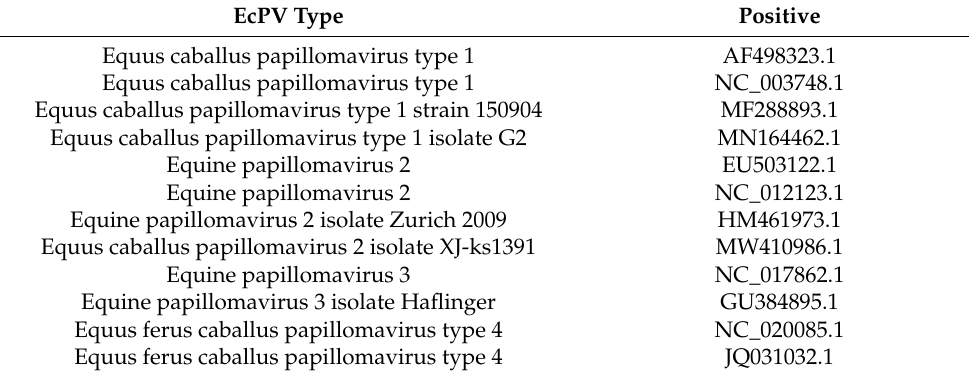
Table 2. List of the EcPV isolates and their related accession numbers included in a house database used for NGS data